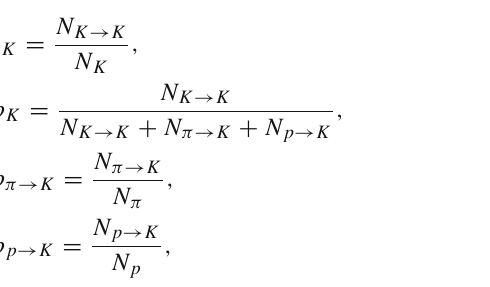
Fig. 6 The scaled spectra of ( I − I K )/σ I using dE / dx measurements alone for particles with a momentum of 5 GeV/c, assuming a 20% degradation. The relative populations are N π = 4 . 4 N K and N K = 2 . 3 N p according to MC simulation. The intersections marked by the arrows are chosen as the cut points